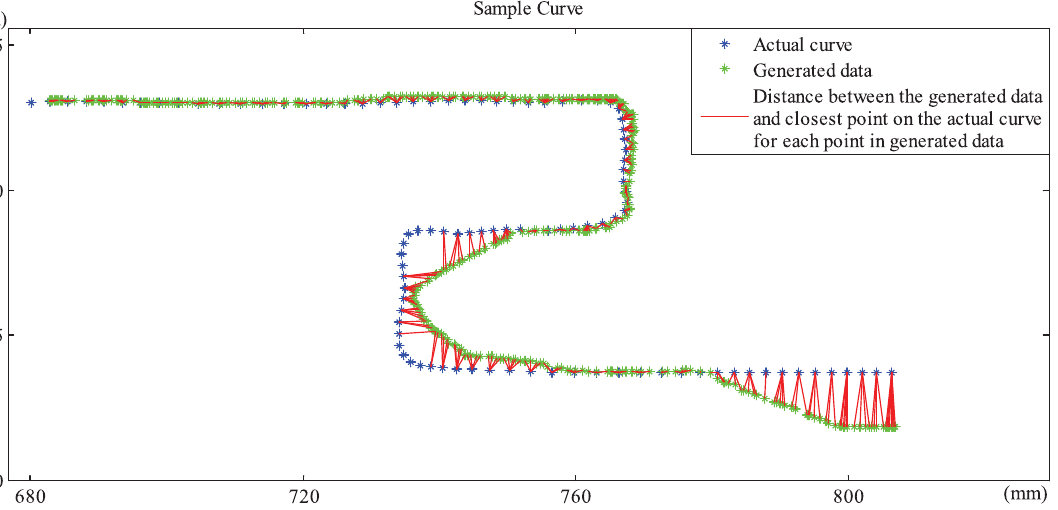
Fig 4. Evaluation of subjects ’ performance in TE. Figure represents a sample curve and a trace path generated by the researcher. The actual points of the curve are colored blue whereas the generated trace path/points are seen in green. In order to evaluate subjects ’ performance in TE, two metrics are studied: the accuracy and the percentage of the tasks accomplished within given time. Using a nearest point search algorithm, the closest points on the actual curve for each point in the subject ’ s trace path are found. The sample in the figure shows the distances between those closest points and the tracked path colored in red. A good performance is represented in the first upper half of the curve where the distance between the closest points and user points are relatively shorter indicating that the user was able to track the path as close to the actual path as